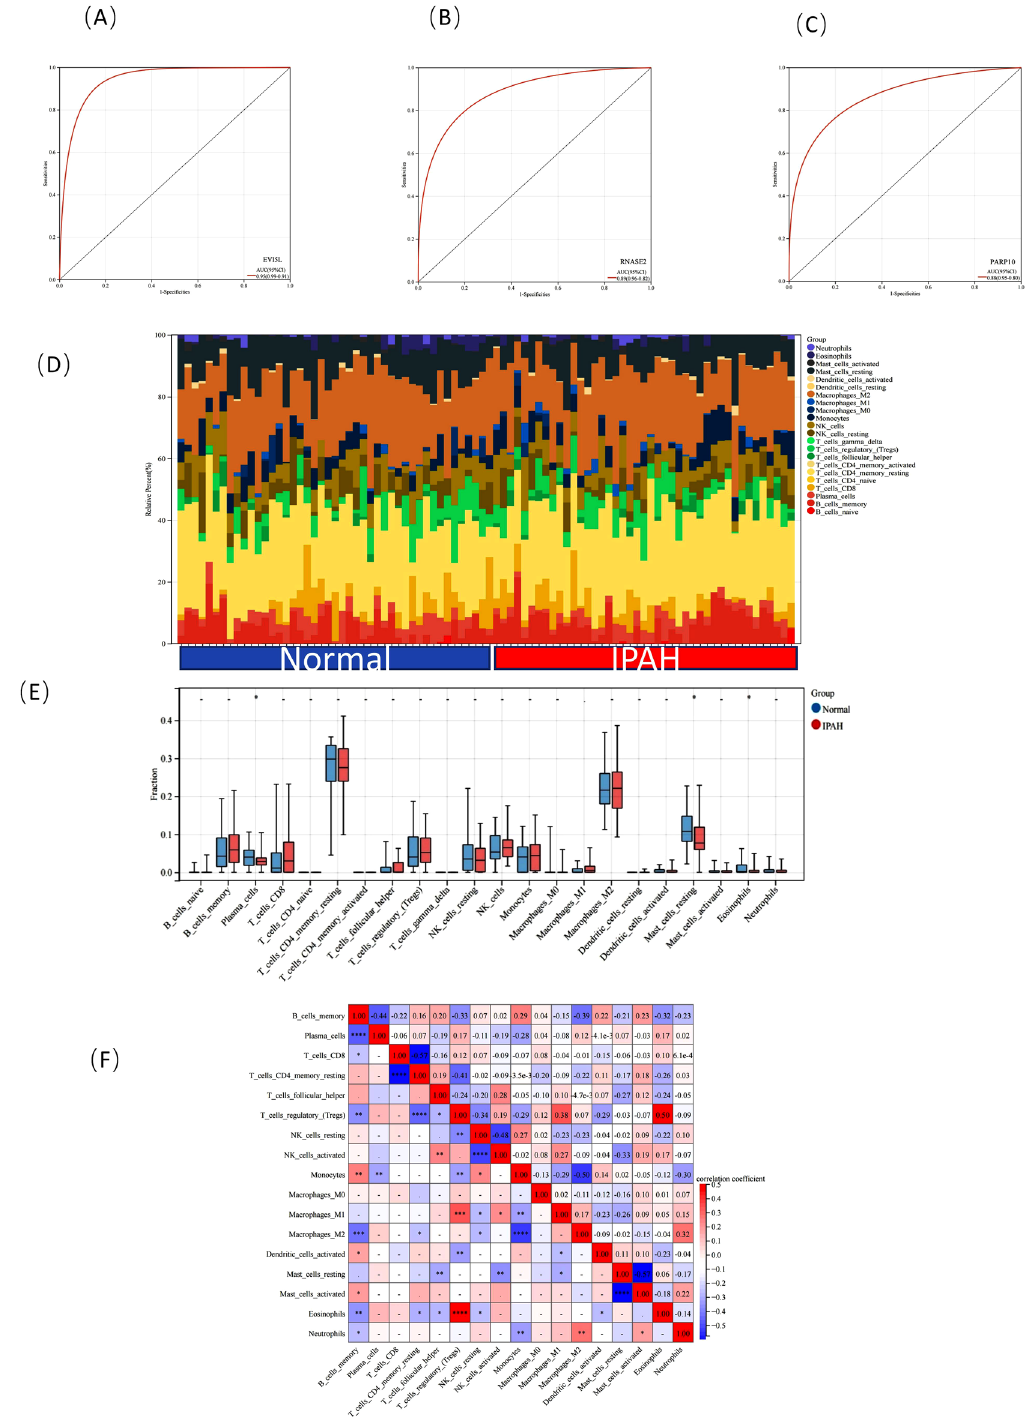
Figure 8. ( A–C ) ROC curve of part of the candidate diagnostic genes: (EVI5L(AUC = 0.95,95%CI 0.91–0.99), RNASE2(AUC = 0.89,95%CI 0.82–0.96), PARP10(AUC = 0.88,95%CI 0.80–0.95). ( D ) Twenty-two immune- infiltrating cell scores were calculated for each sample. Using Barplot to visualize the proportion of each type of immune cell in different samples. ( E ) Comparison of immune cells with different proportions between IPAH and control groups. ( F ) IPAH immune cell ratio-related heat map. Red represents a positive correlation and blue represents a negative correlation. Figure 8 is drawn by R software program (version 3.40.6; R Foundation for Statistical Computing, Vienna, Austria, https:// www.r- proje ct.